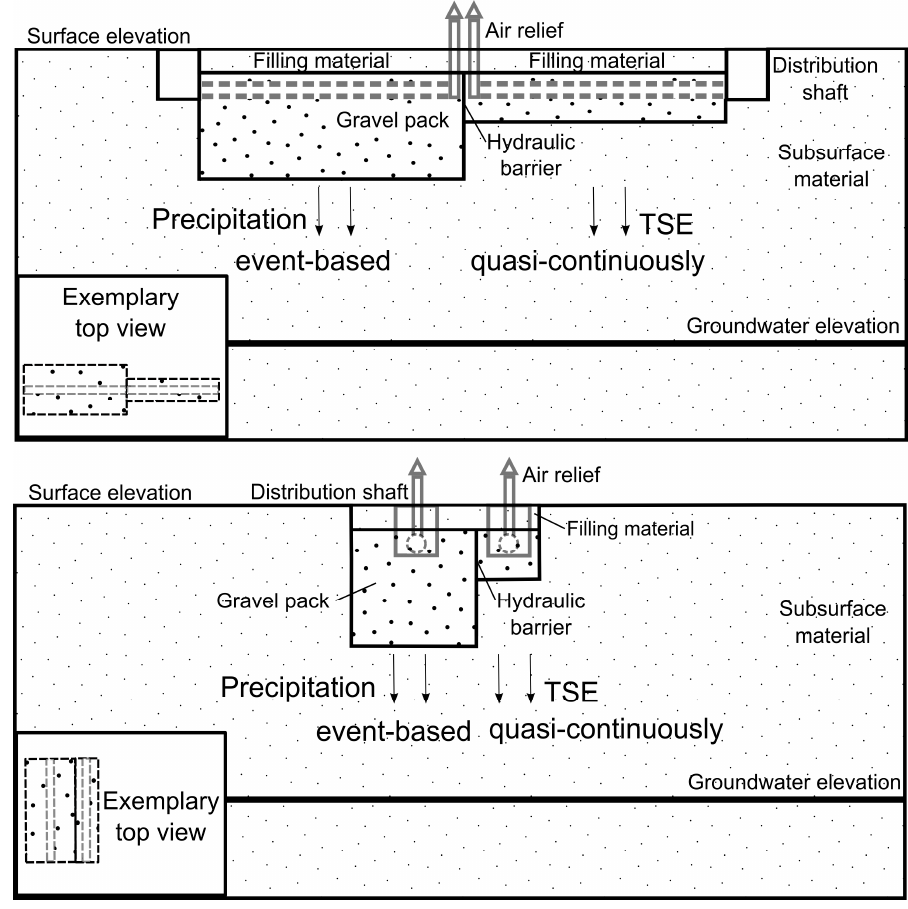
Figure 1. Scheme of two possible designs for a closely-spaced infiltration of precipitation water and treated wastewater (treated sewage effluent TSE), not to scale, based on References